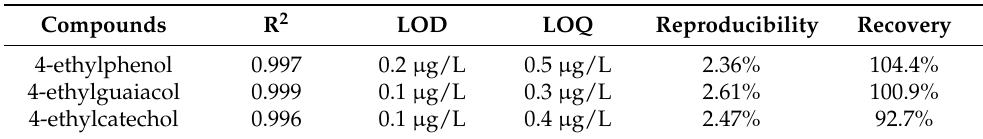
Table 1. Calibration and validation data of the method for the analysis of the impact compounds of “animal” phenolic